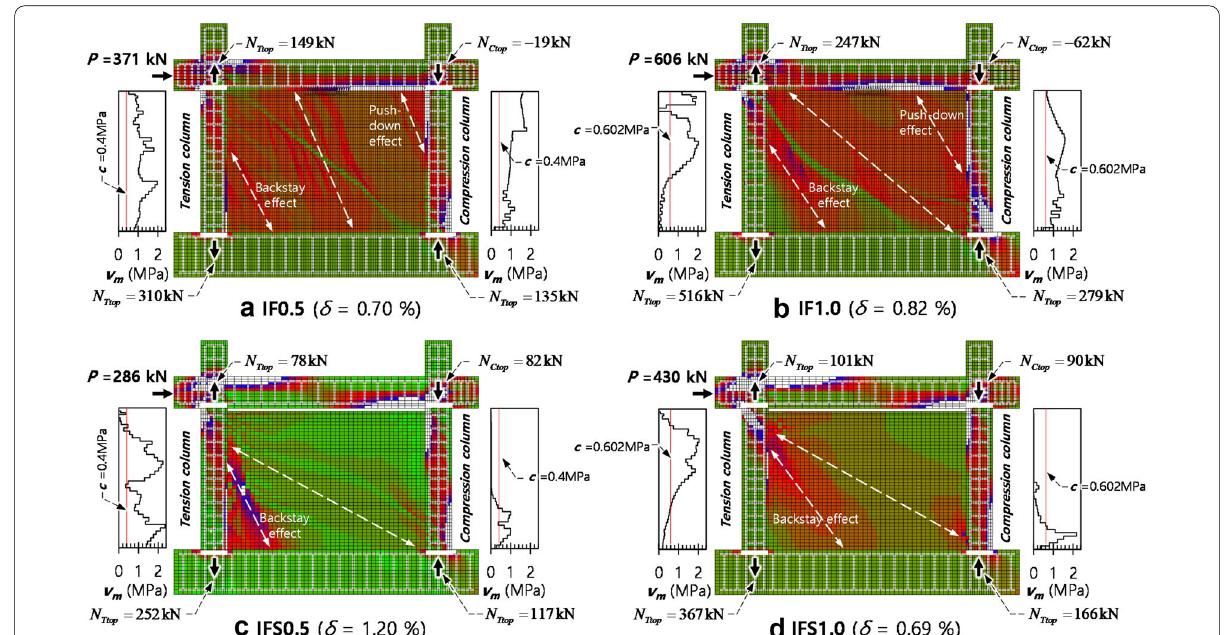
Fig. 11 Distributions of interface shear stresses on the boundary of masonry infill and concrete